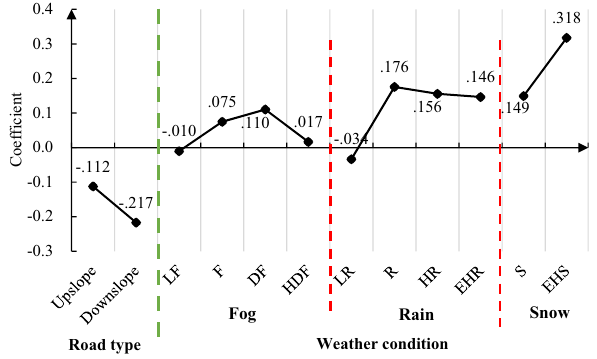
Fig. 7 Coefficients of weather condition and road